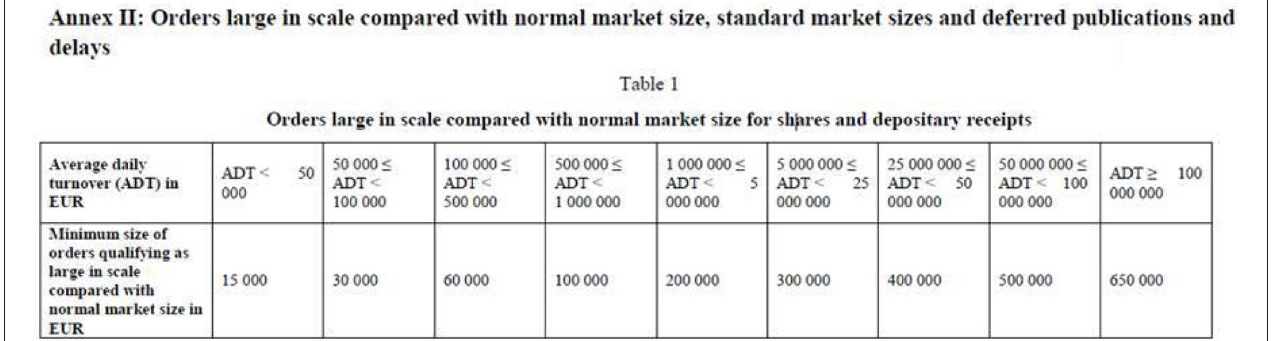
FIGURE 1 | ESMA Large in Scale table. Regulatory technical and implementing standards – Annex I.